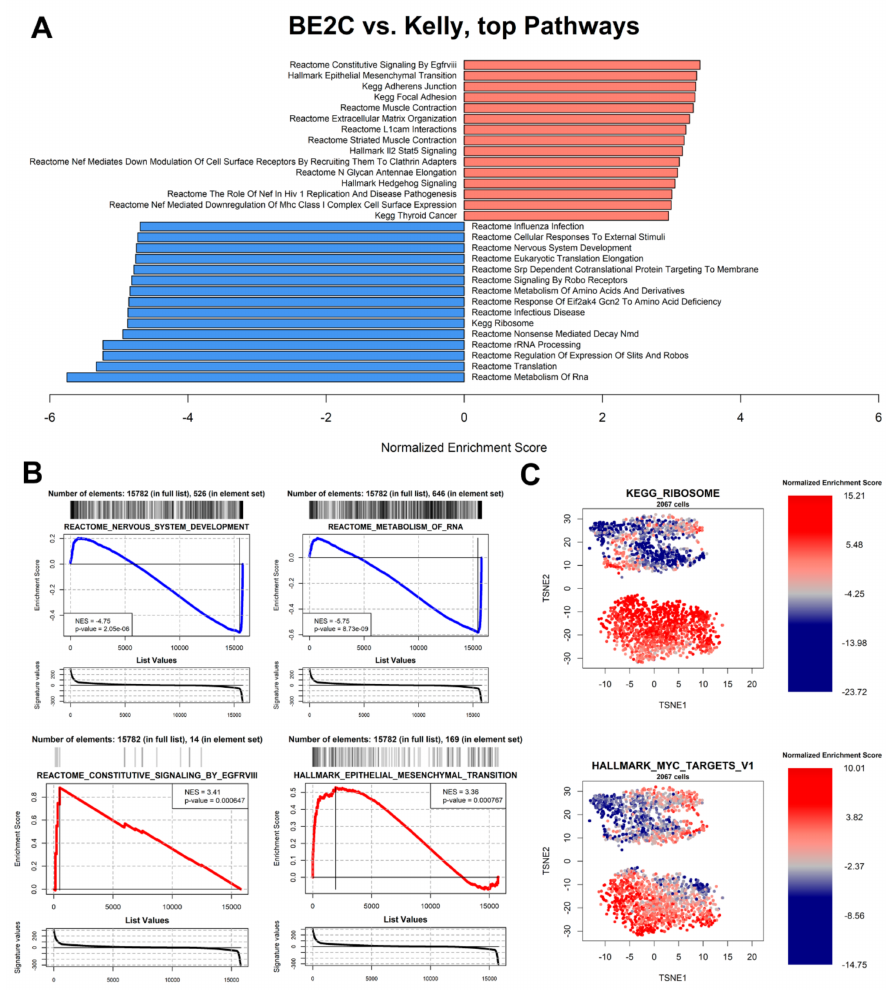
Figure 5. Pathway enrichment analysis. ( A ) Top ten upregulated and top ten downregulated pathways in the BE2C vs. Kelly cells comparison. The score is calculated using gene set enrichment analysis (GSEA) [36] as normalized enrichment score (NES). ( B ) Individual GSEA running score plots of four selected pathways in the BE2C vs. Kelly comparison. ( C ) Single-cell-specific NES of two selected pathways in the dataset. BE2C cells are on top, following the same cartesian coordinates as Figure